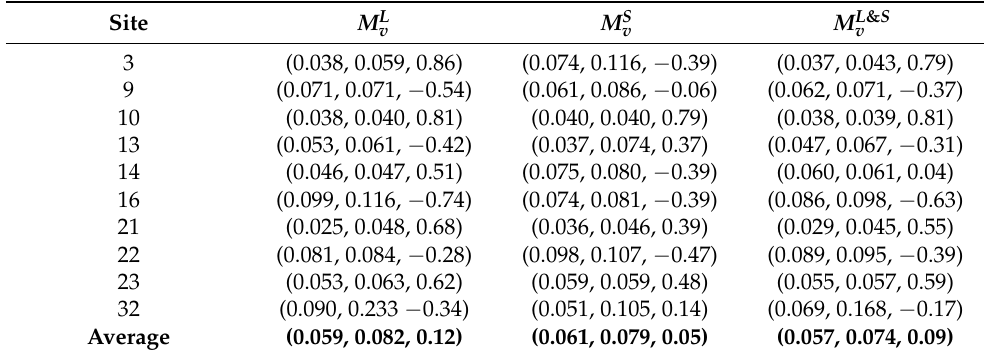
Table 6. Soil moisture retrieval validation at soybean fields; Within parenthesis are unbiased RMSE in m 3 /m 3 , RMSE in m 3 /m 3 and correlation.